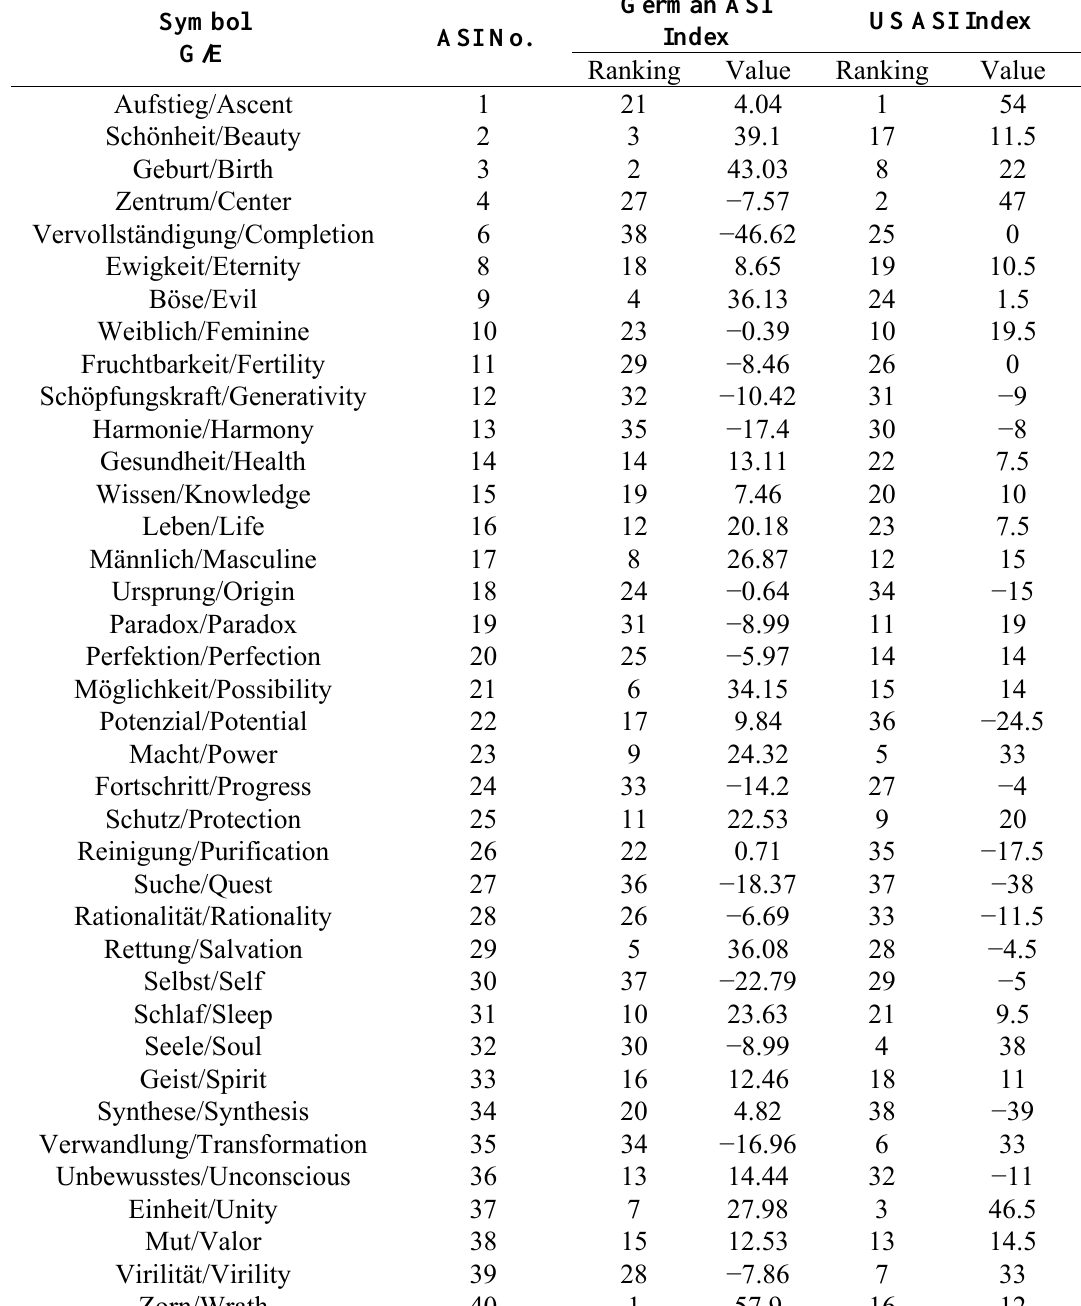
Table 3. Swiss-German ASI Index and US-English ASI Index Comparison. Symbol ASI G/E